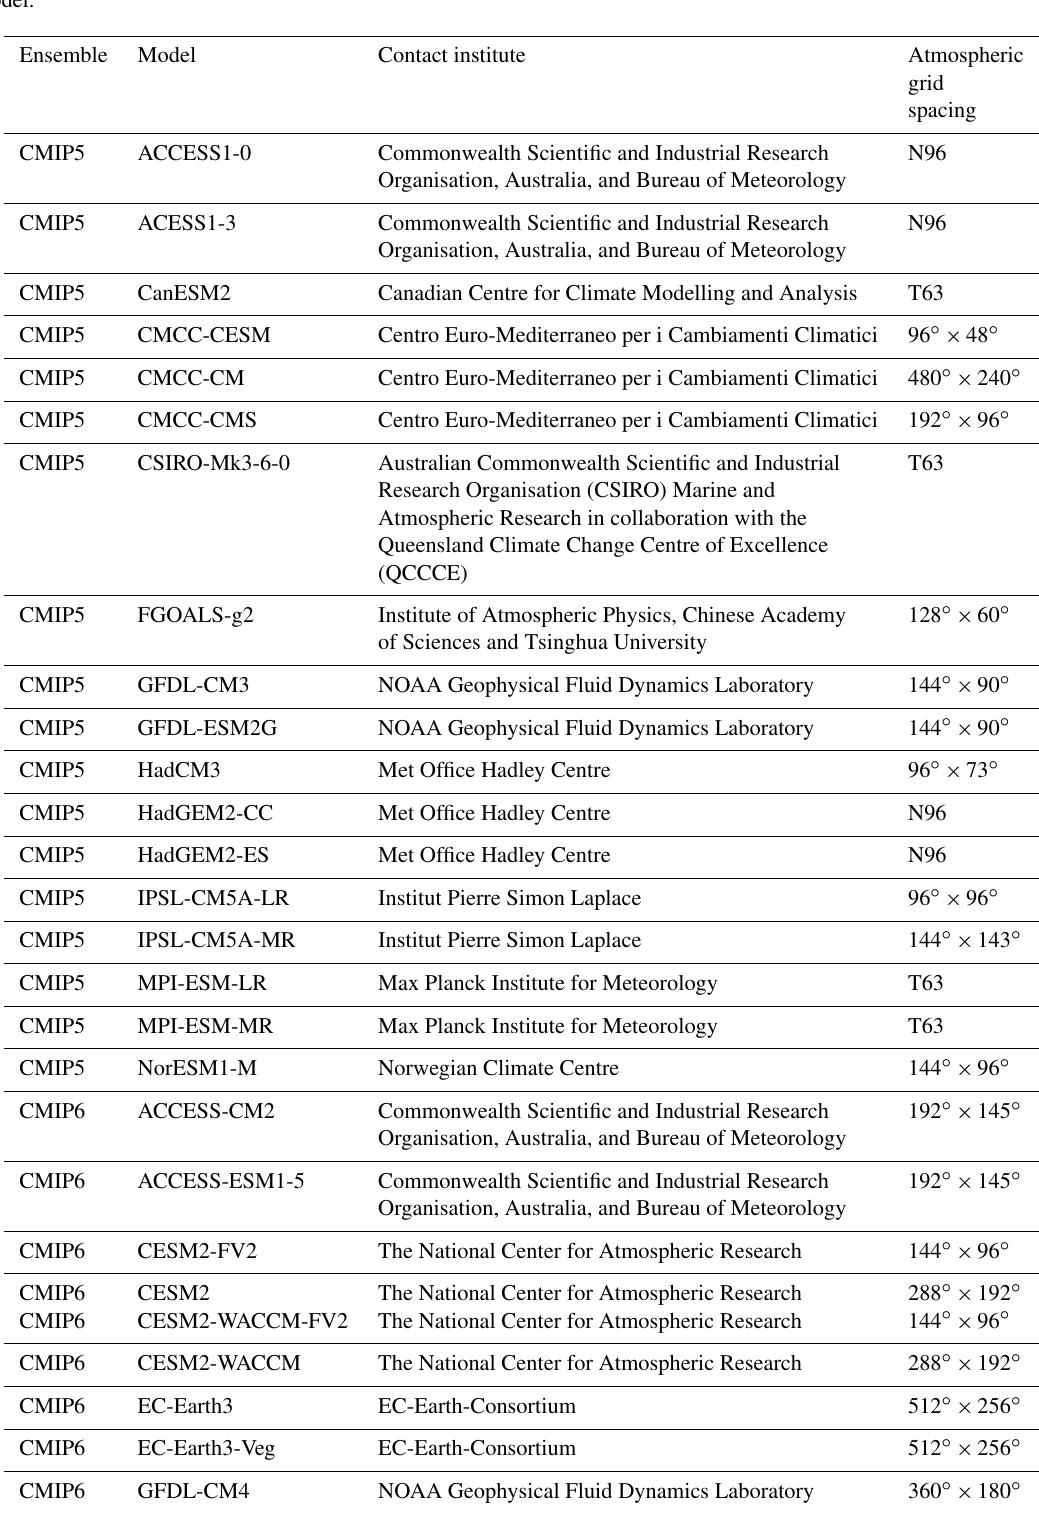
Table 1. The GCM ensembles used in this study and the GCMs they consist of. Grid spacing is given in the same format as in the meta-data for each